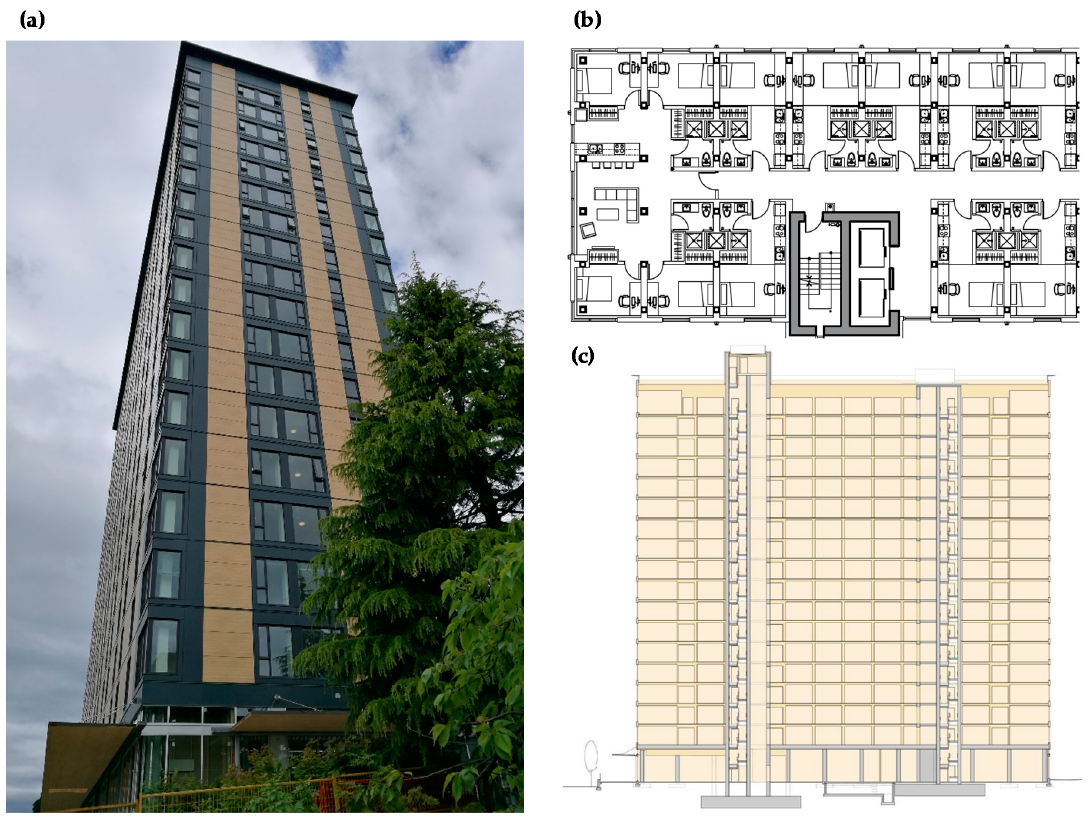
Figure 1. TWB : ( a ) building, ( b ) typical floor plan (partial section) and ( c ) longitudinal section (courtesy Acton Ostry Architects Inc., Vancouver, BC, Canada).